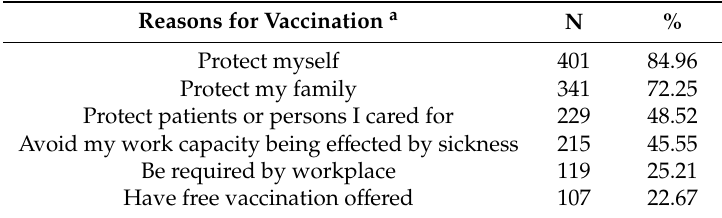
Table 4. Reasons for influenza vaccination receipt- Internet panel survey, China, 2018–2019 season (N = 472).